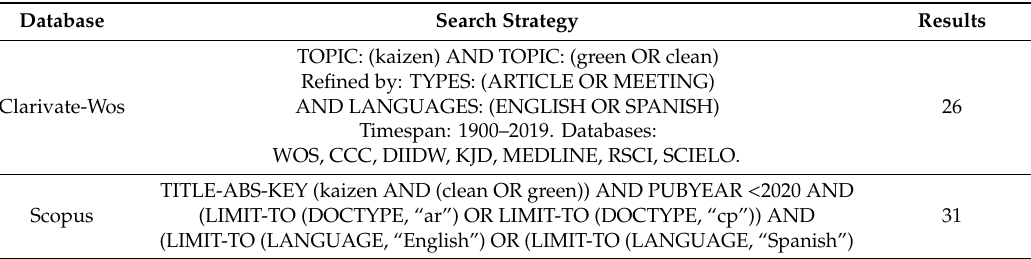
Table 1. Search strategies by authors 1 and